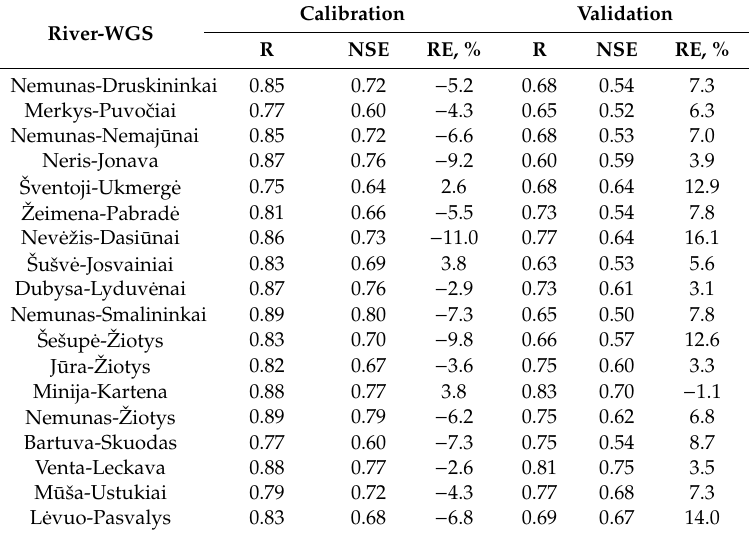
Table 2. Results of calibration and validation of hydrological